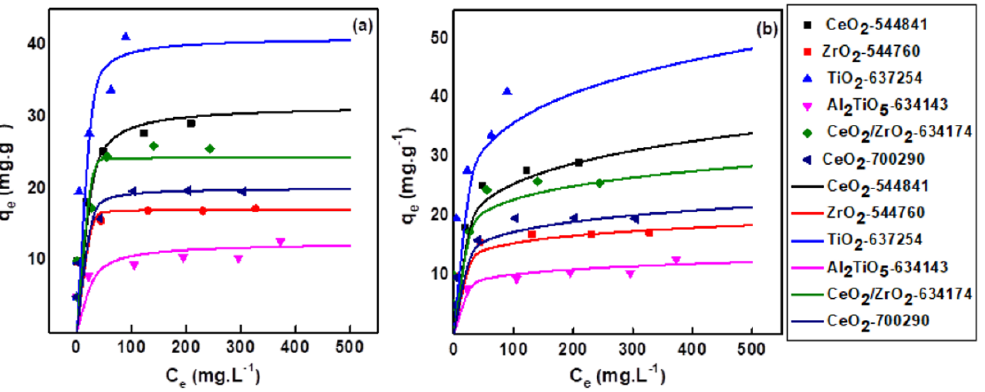
Figure 3. Adsorption isotherms: ( a ) Langmuir and ( b ) Freundlich of CA- 99 Mo on different metal oxides NPs.